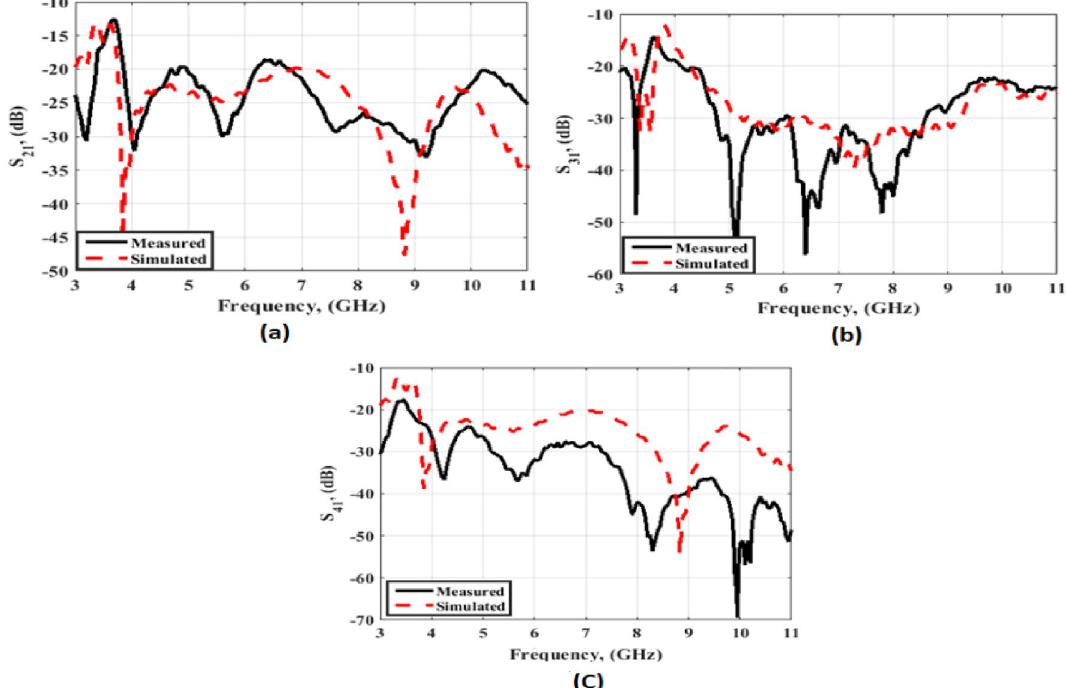
Figure 9. Transmission coefficients outcomes of the flexible MIMO antenna ( a ) S 21 , ( b ) S 31 , ( c ) S 41